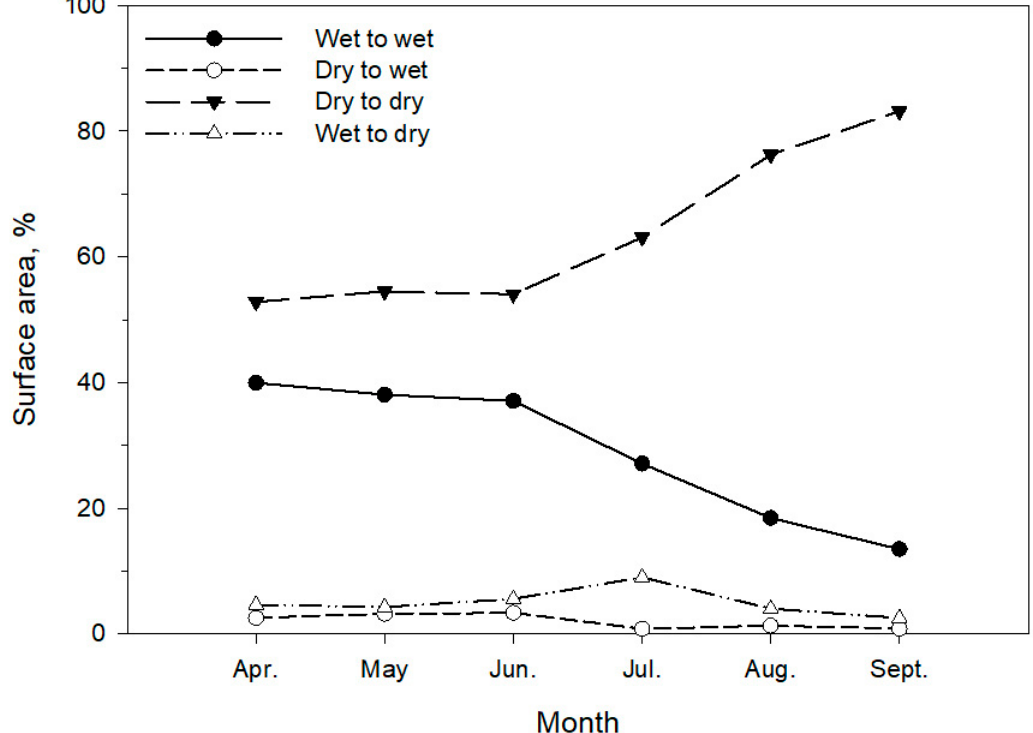
Figure 2. Average monthly (arithmetic mean) percent of total surface area for the wet to wet, dry to wet, dry to dry, and wet to dry states of seasonal Prairie Pothole Region wetlands.